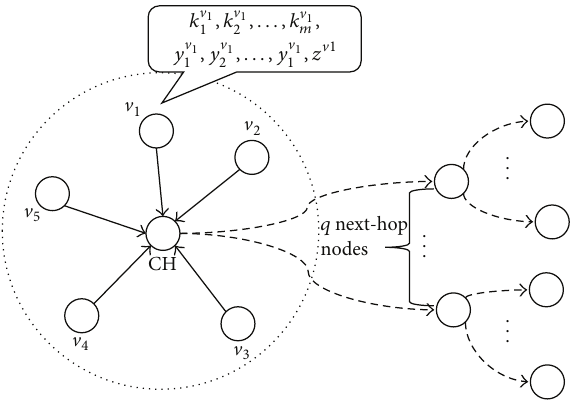
Figure 1: Postdeployment phase of